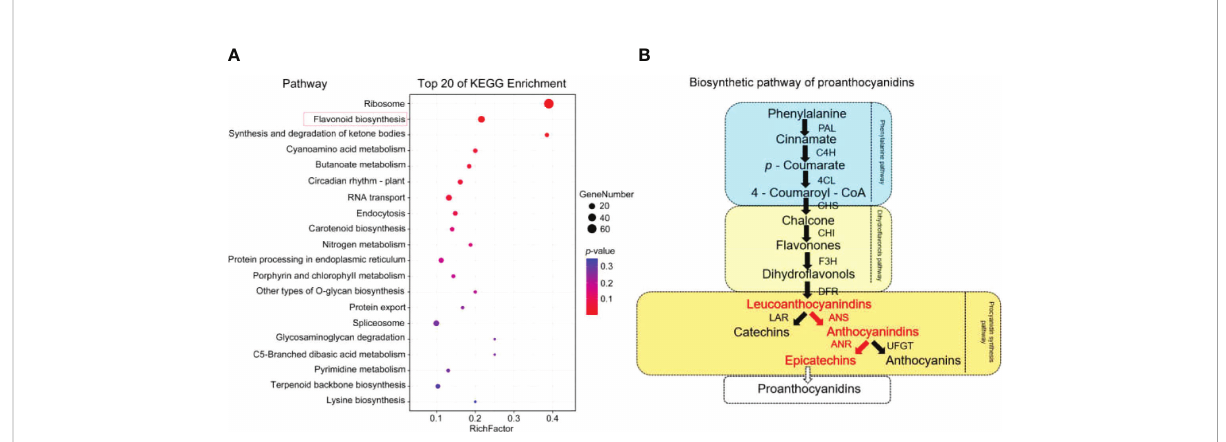
FIGURE 4 KEGG enrichment analysis of candidate genes and the main enriched pathways. (A) KEGG enrichment analysis map. (B) Biosynthesis pathway of procyanidins (the red text indicates the components of the synthesis pathway of EC).